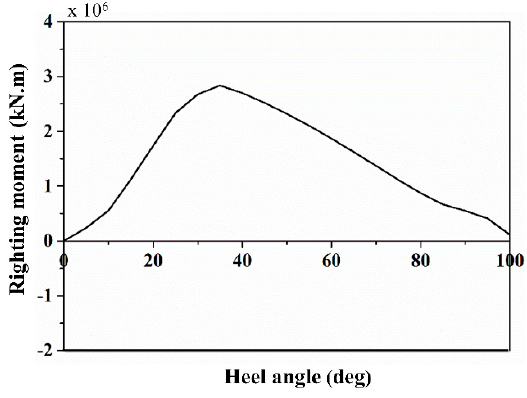
Figure 5. Stability curve of the WSA: righting moment vs. heel angles.